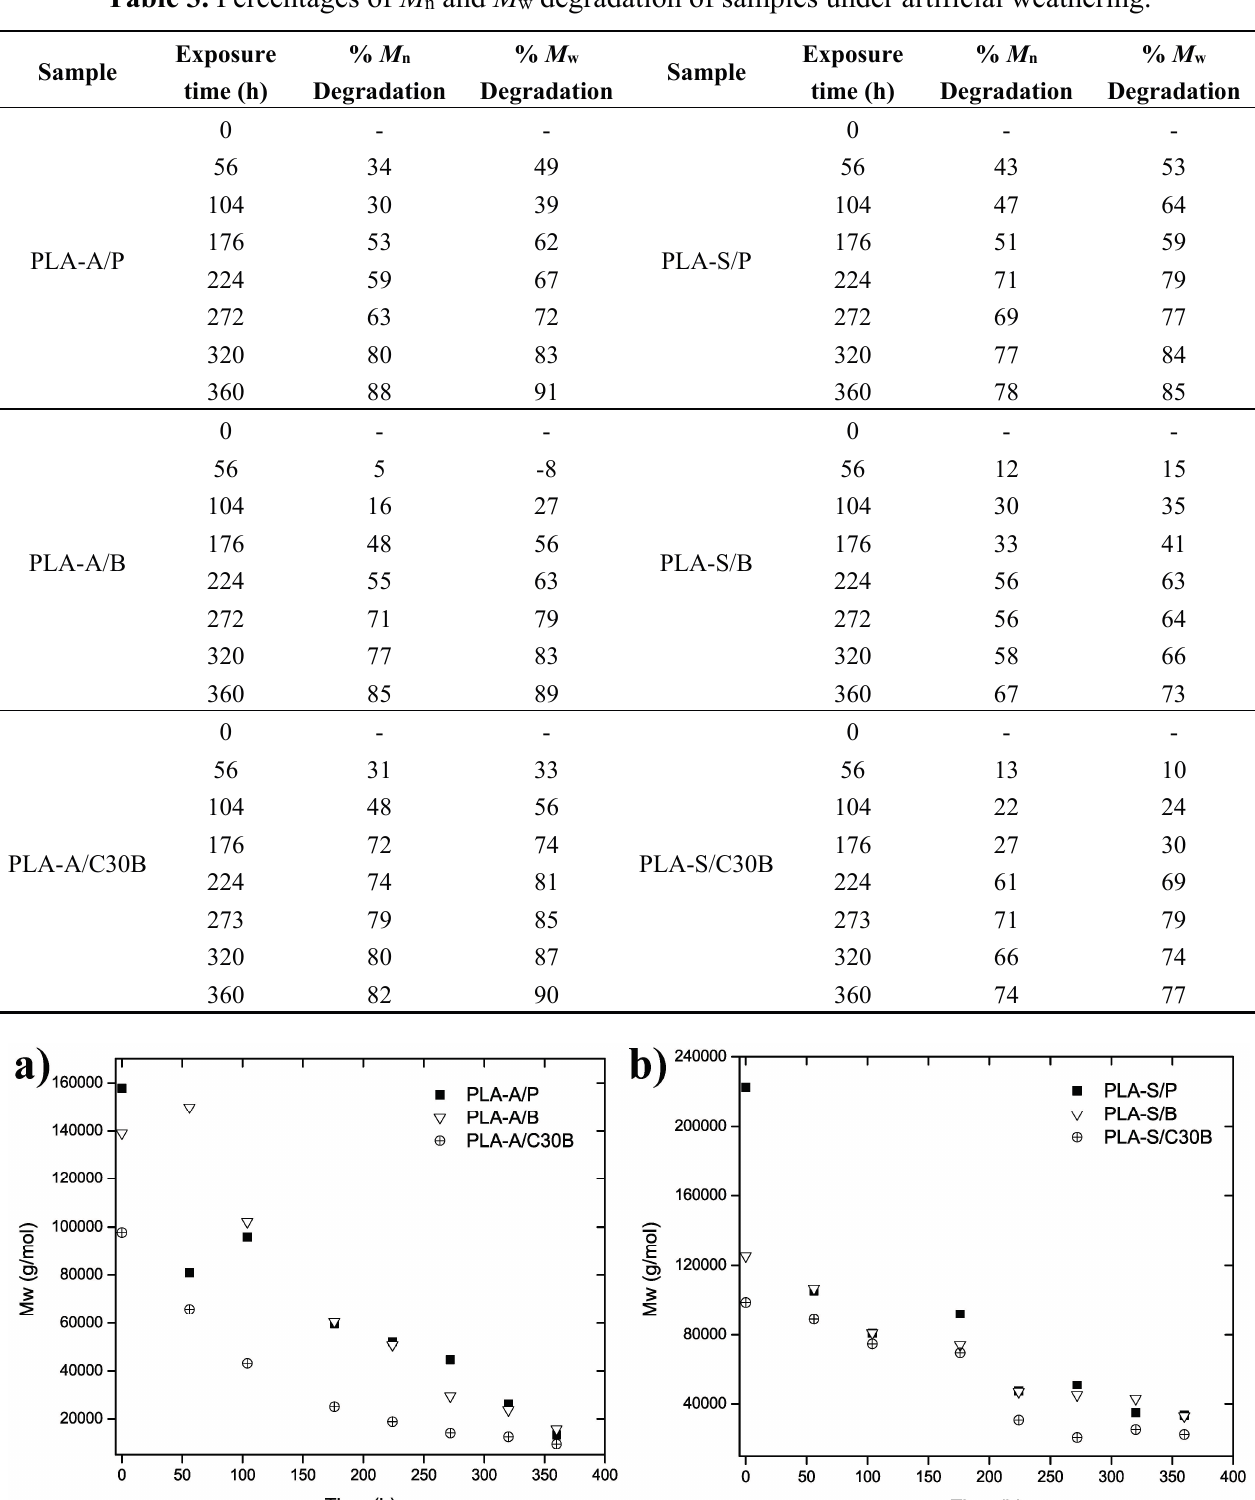
Figure 5. M w decrease of ( a ) amorphous and ( b ) semicrystalline PLA with increasing exposure time to artificial